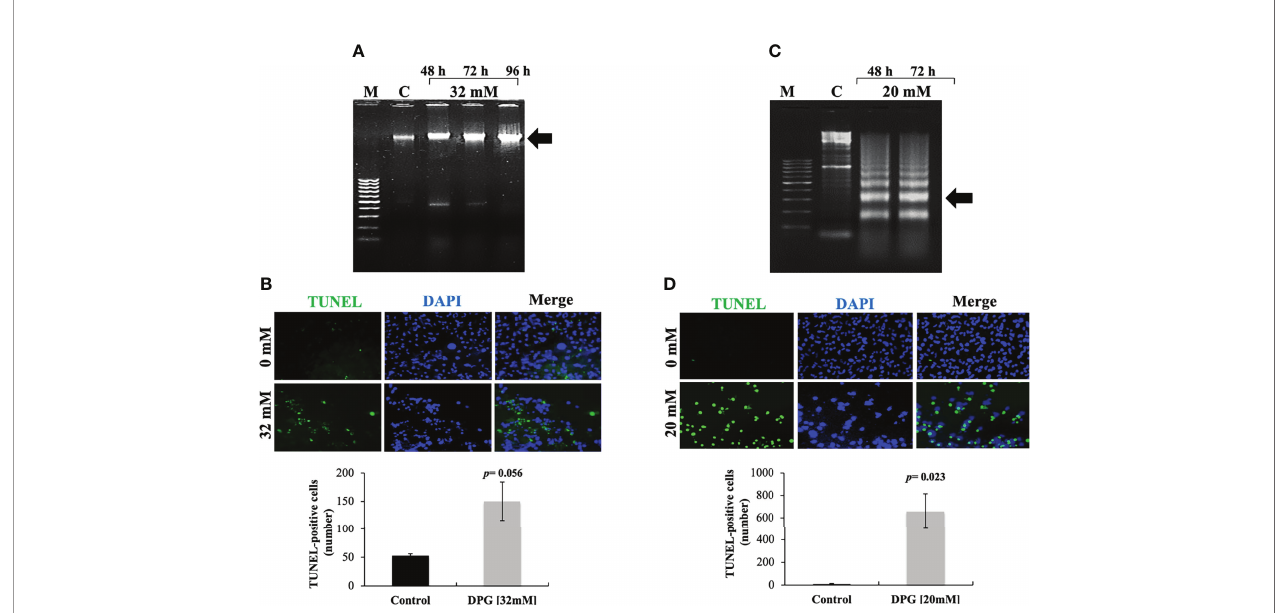
FIGURE 2 | Apoptotic effects of dipotassium glycyrrhizinate (DPG) on glioblastoma cell lines. (A) U251 cells were incubated with 32 mM of DPG for 48, 72, and 96 h. Genomic DNA was isolated and analyzed on 1.5% agarose gel stained with ethidium bromide. M, DNA marker 100 base pairs; C, untreated control cells. (B) U251 cells were treated with DPG (32 mM for 96 h). After incubation with DPG, TUNEL-positive cells were quanti fi ed by the ImageJ computer program. (C) U138MG cells were incubated with 20 mM of DPG for 48 and 72 h. Genomic DNA was isolated and analyzed on 1.5% agarose gel stained with ethidium bromide. M, DNA marker 100 base pairs; C, untreated control cells. (D) U138MG cell lines were treated with DPG (20 mM for 72 h). After incubation with DPG, TUNEL-positive cells were quanti fi ed by the ImageJ computer program. The data presented are mean ± standard deviation of the experiments performed in triplicate. The results showed that treatment with DPG increased the number of cells undergoing apoptosis compared to untreated control cells (U251: p -value = 0.056; U138MG: p -value =